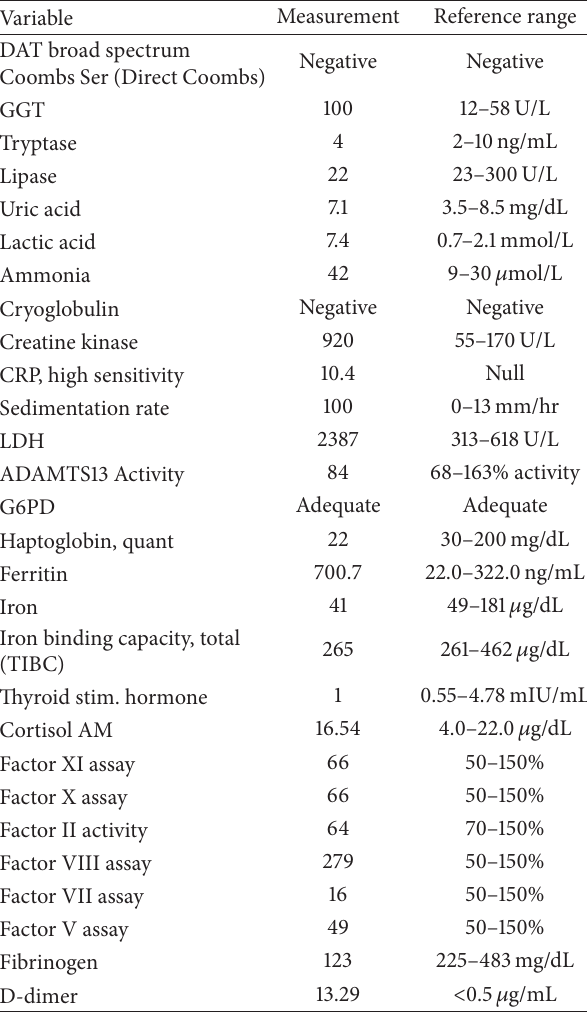
Table 2: Additional labs. Table 3: Autoimmune and infectious